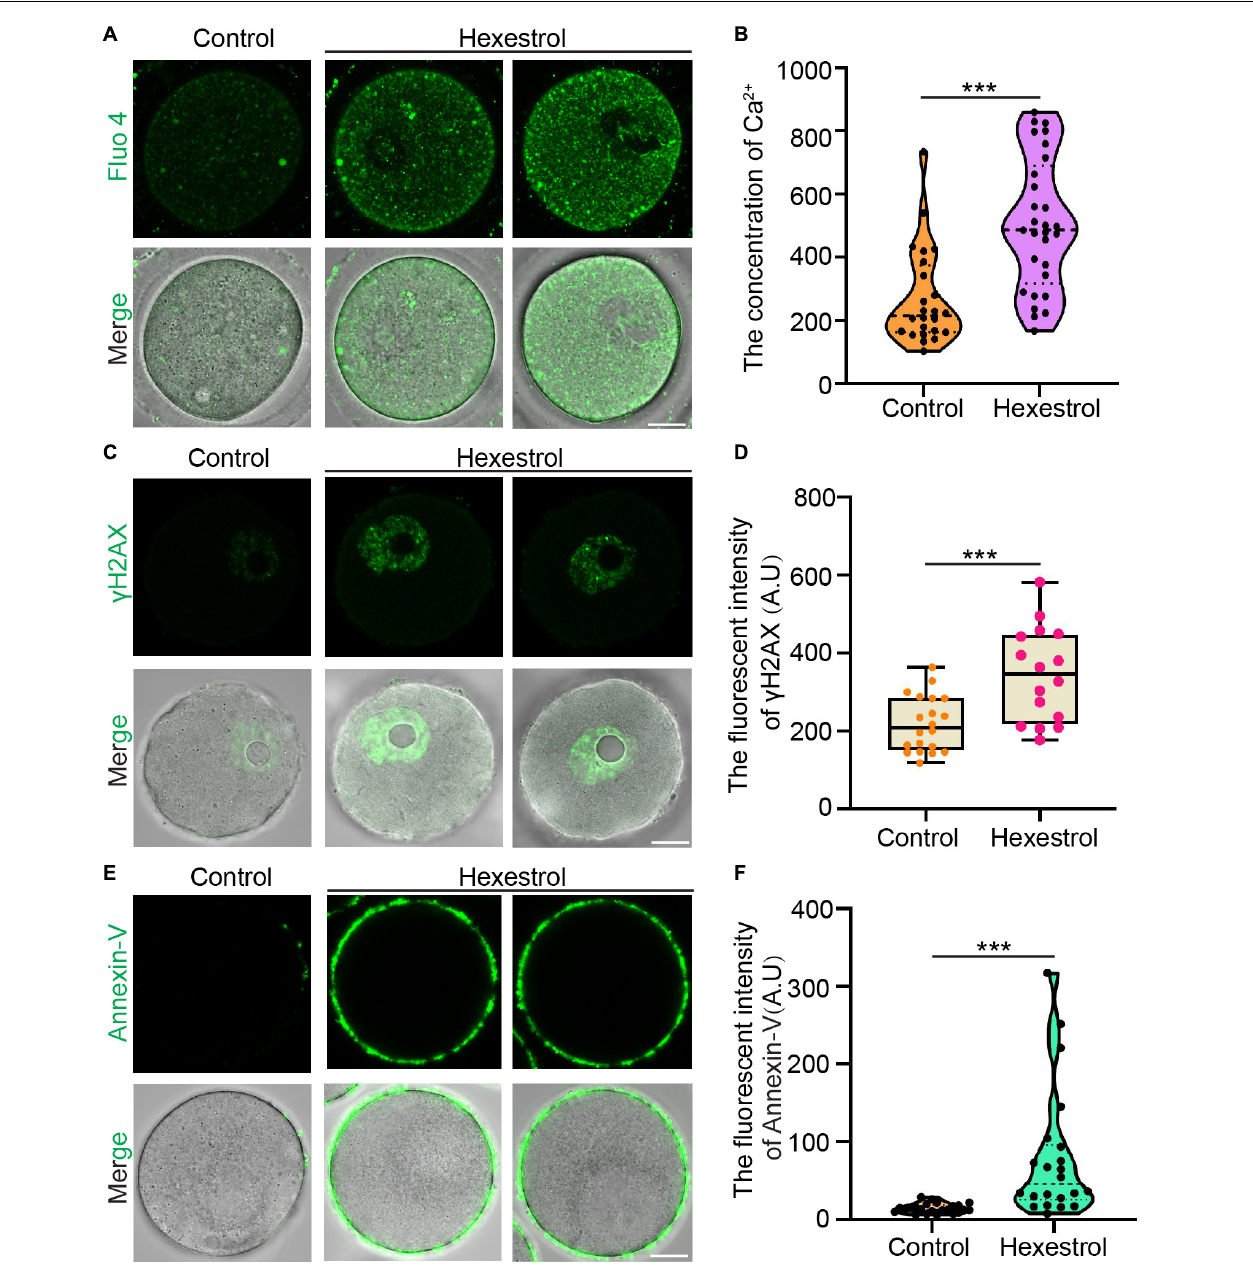
FIGURE 6 | HES increases intracellular calcium level and DNA damage to induce oocyte apoptosis. (A) Representative images of Ca 2 + levels in control and HES-exposed oocytes. Scale bar, 20 µ m. (B) Fluorescent intensity of Ca 2 + was quantified in control and HES-exposed oocytes. *** P < 0.001. (C) Representative images of γ H2AX localization in control and HES-exposed oocytes. Scale bar, 20 µ m. (D) Fluorescent intensity of γ H2AX was recorded in control and HES-exposed oocytes. *** P < 0.001. (E) Representative images of apoptotic oocytes in control and HES-exposed oocytes. Scale bar, 20 µ m. (F) Fluorescent intensity of annexin-V was quantified in control and HES-exposed oocytes. *** P < 0.001. Data are represented as mean ± SD from at least three independent